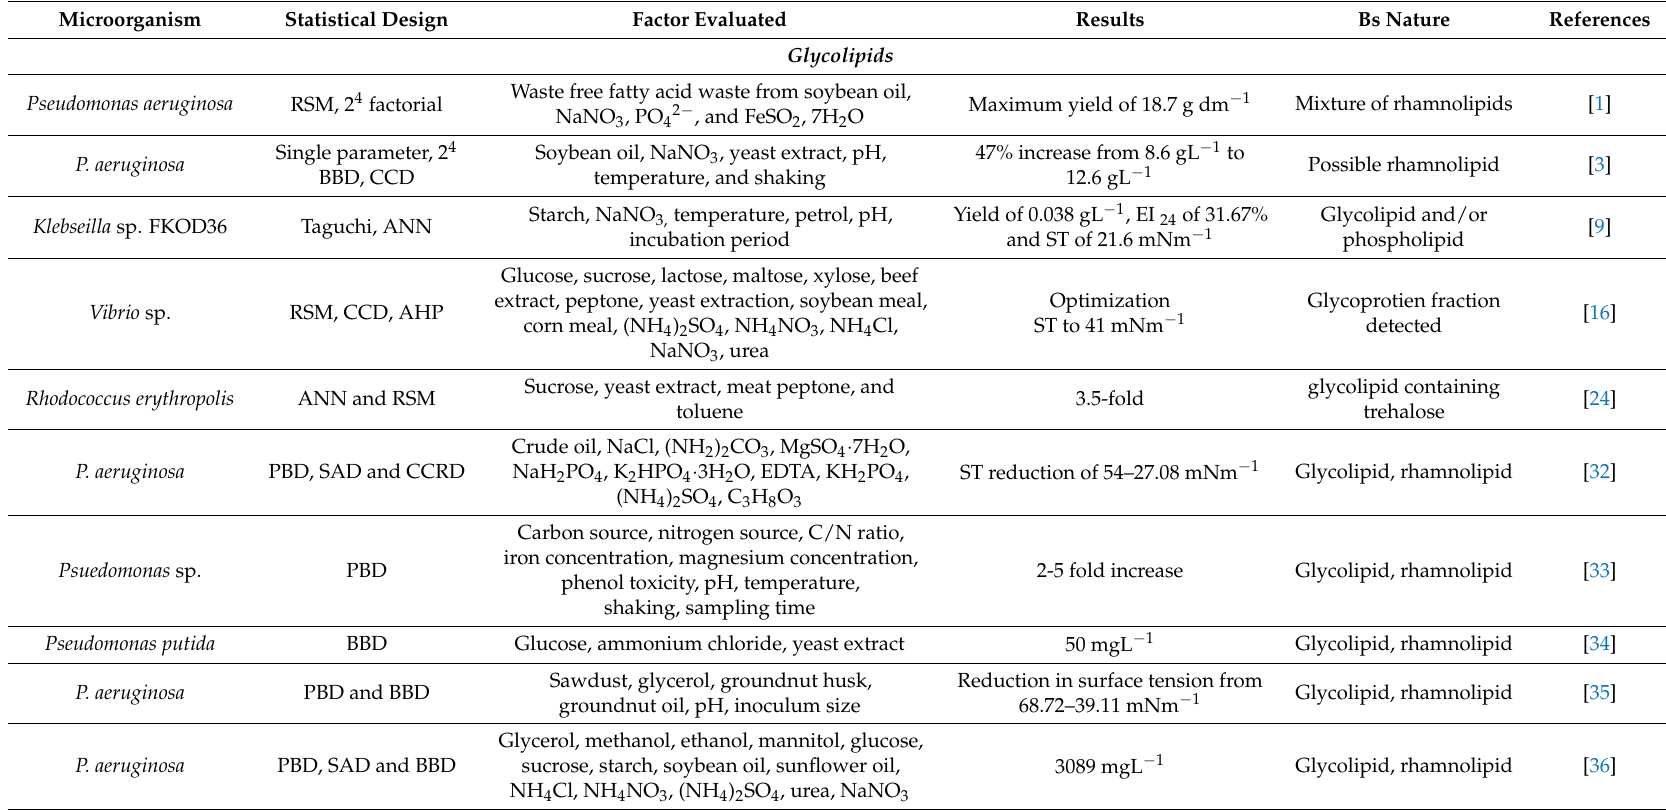
Table 1. Summary of different statistical strategies used for optimizing biosurfactants (Bs)